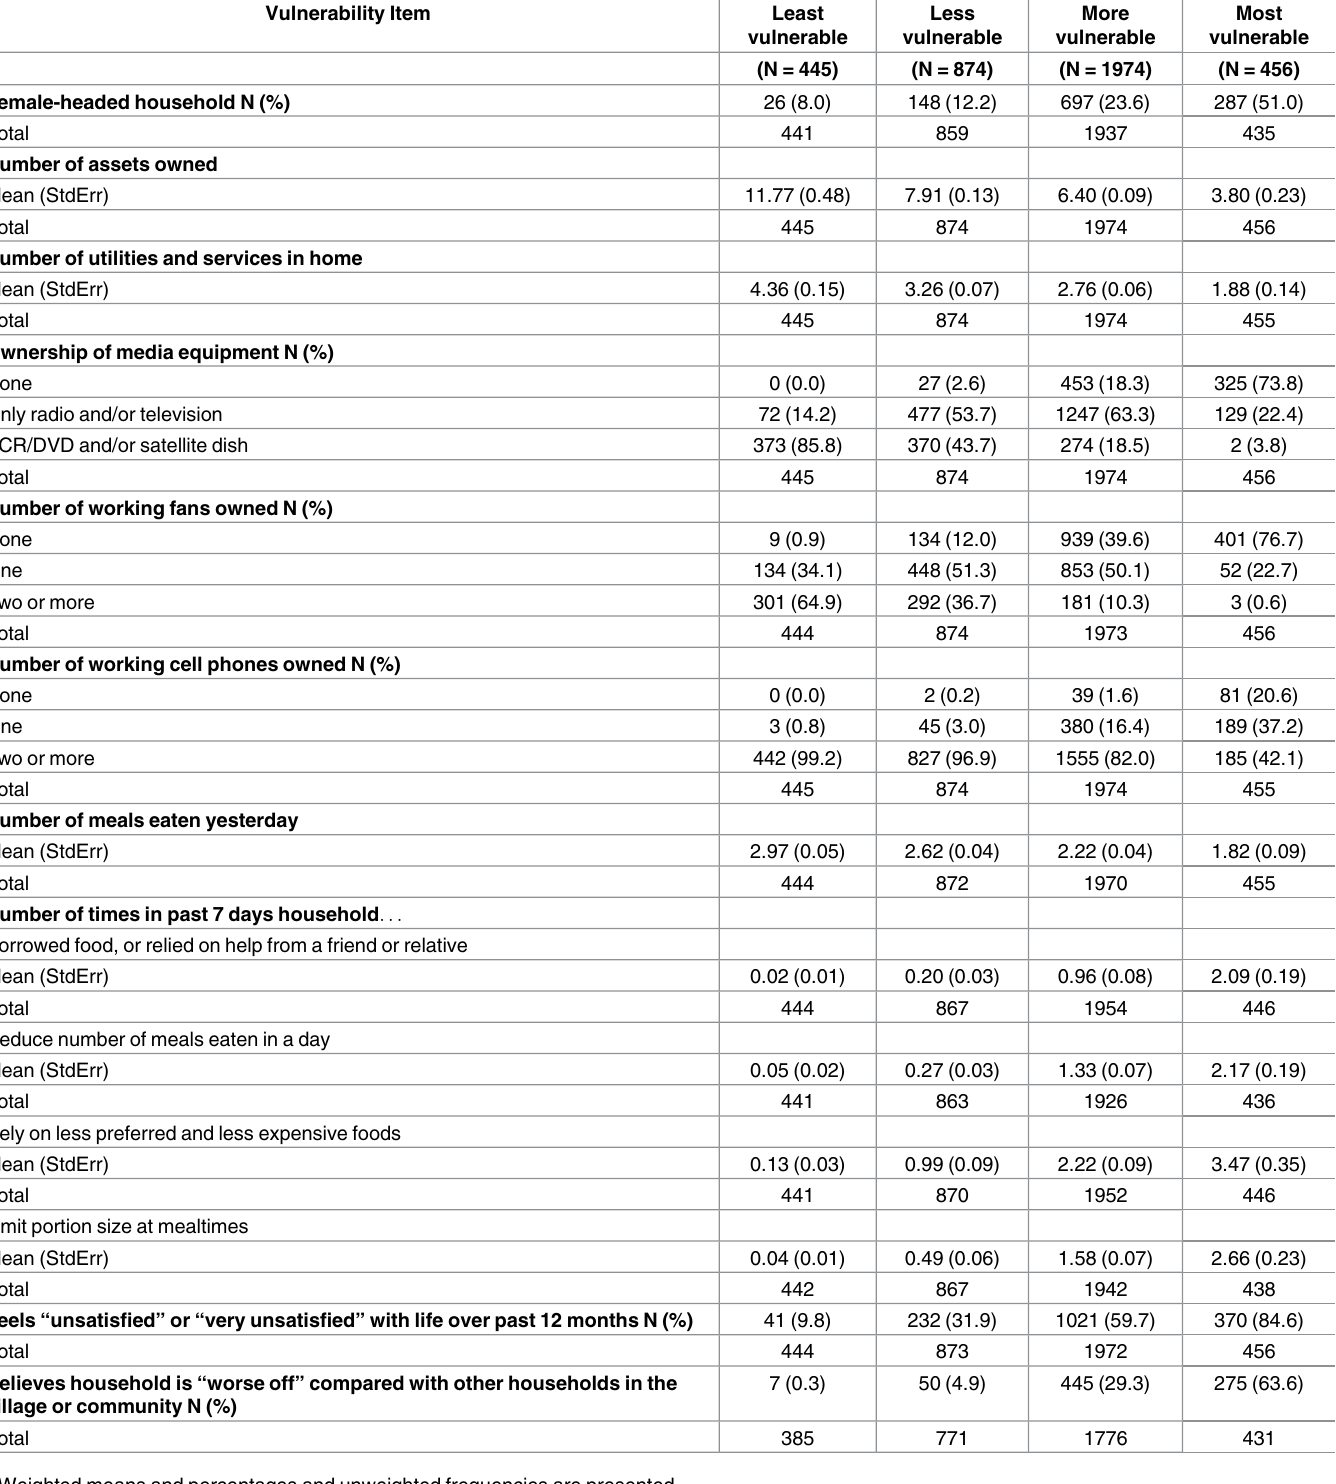
Table 2. Component 1 household characteristics by vulnerability levels.